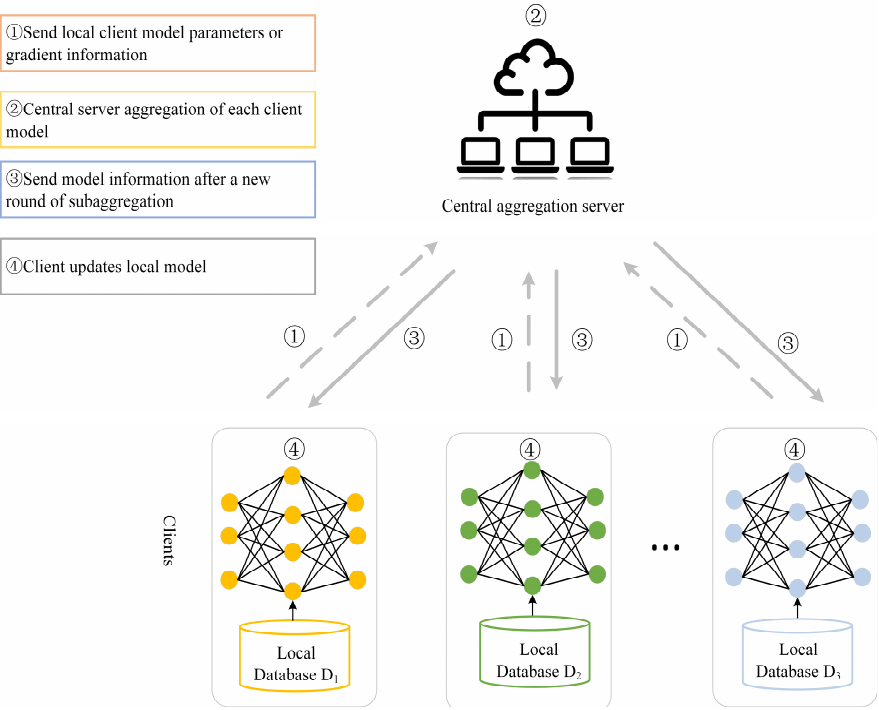
Figure 1. Classic architecture of federated learning.